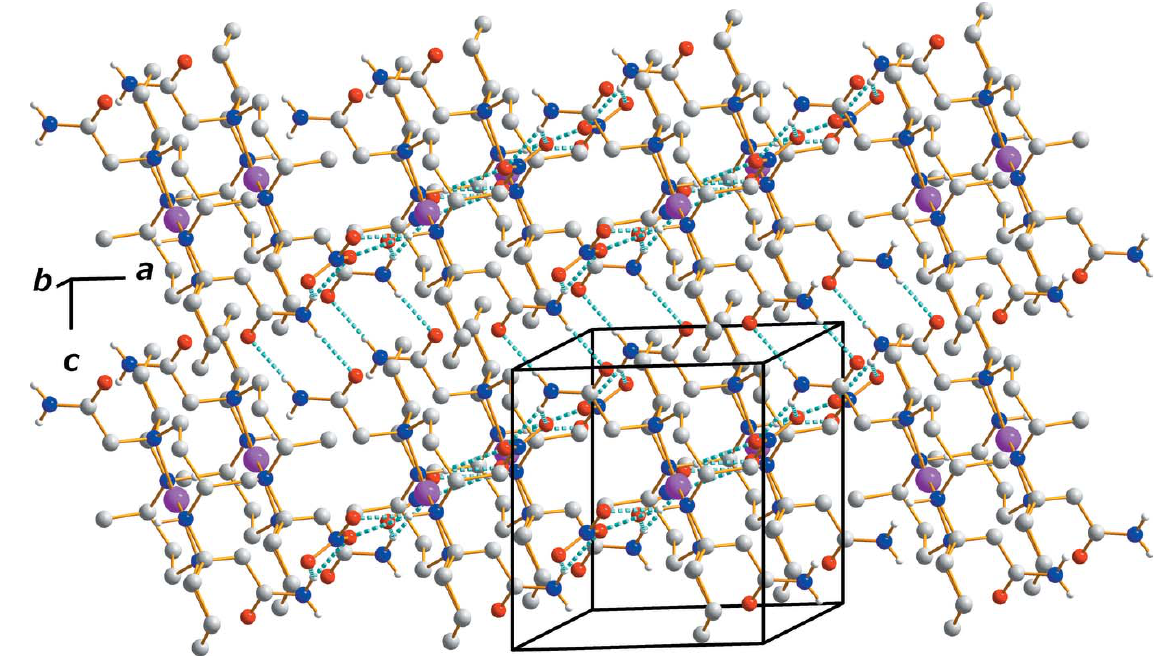
Figure 2 The crystal packing in complex (I), viewed along the b -axis direction. Dashed lines represent N—H (cid:2)(cid:2)(cid:2) O hydrogen-bonding